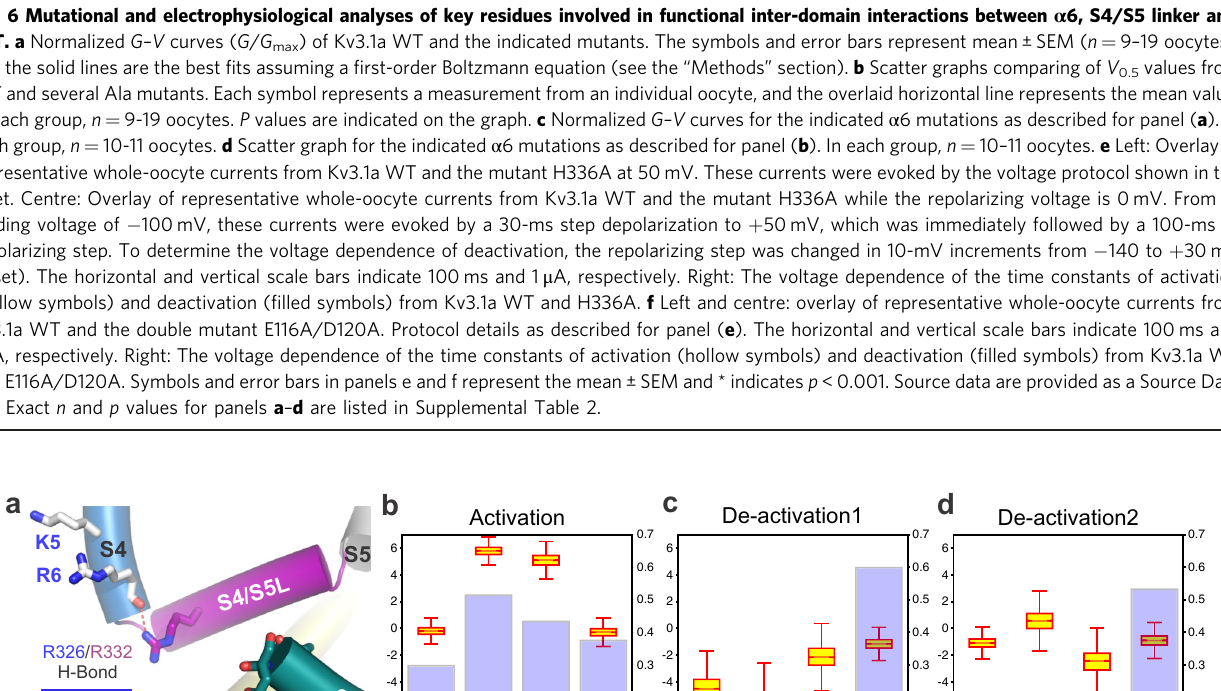
region (H381 and H383, see Fig. 8b). Again, mutation of these the H381A/H383A double mutant had the same dramatic phe- notype as the H212A mutant 51 . The side chains of H381 and H383 are interacting with Q372 and Q409, respectively, and